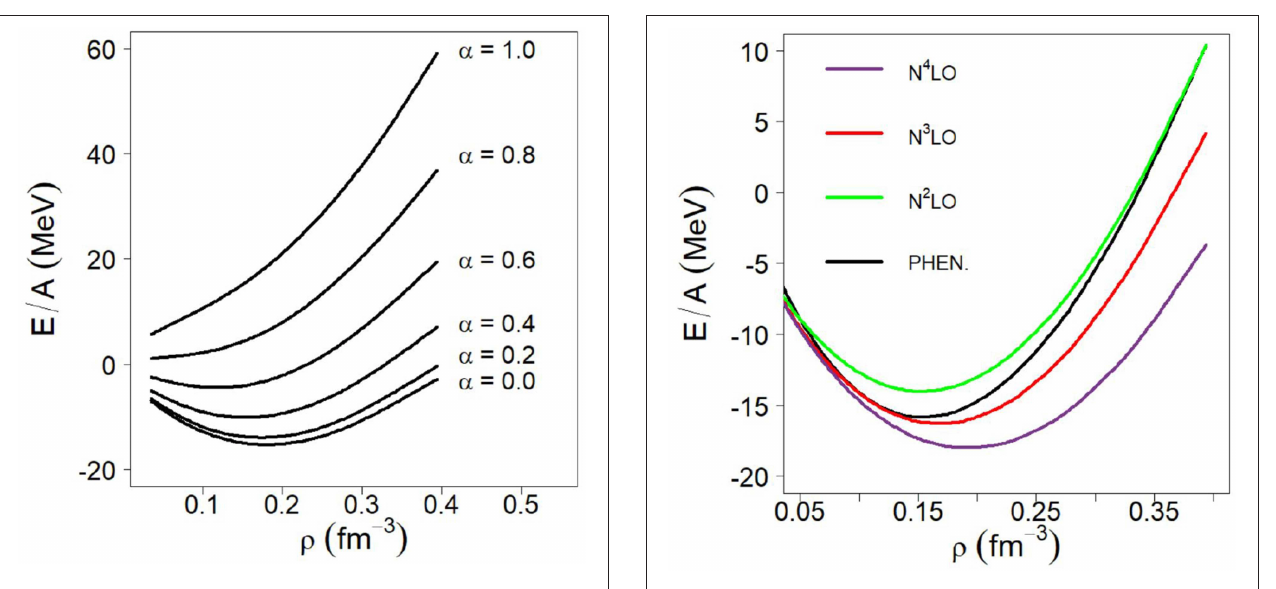
FIGURE 6 | Energy per particle in isospin-asymmetric nuclear matter. In each case, the isospin asymmetry parameter is given. Calculations conducted at N 3 LO of the 2NF (and the 2PE 3NF included up to N 3 LO) with cutoff equal to 500 MeV.